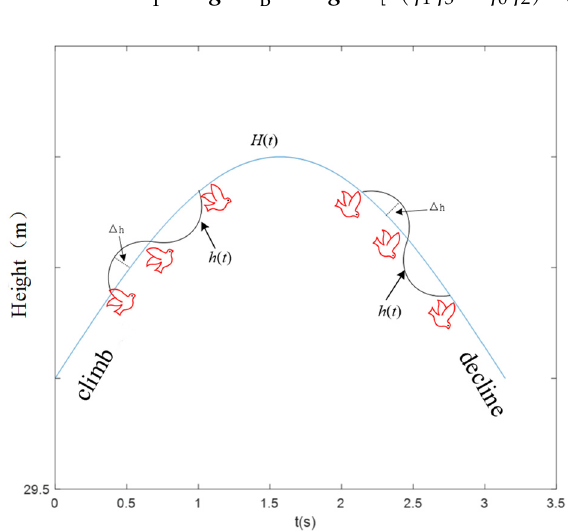
Figure 12. Centroid height variation curve and periodic equivalent height during maneuvering flight.